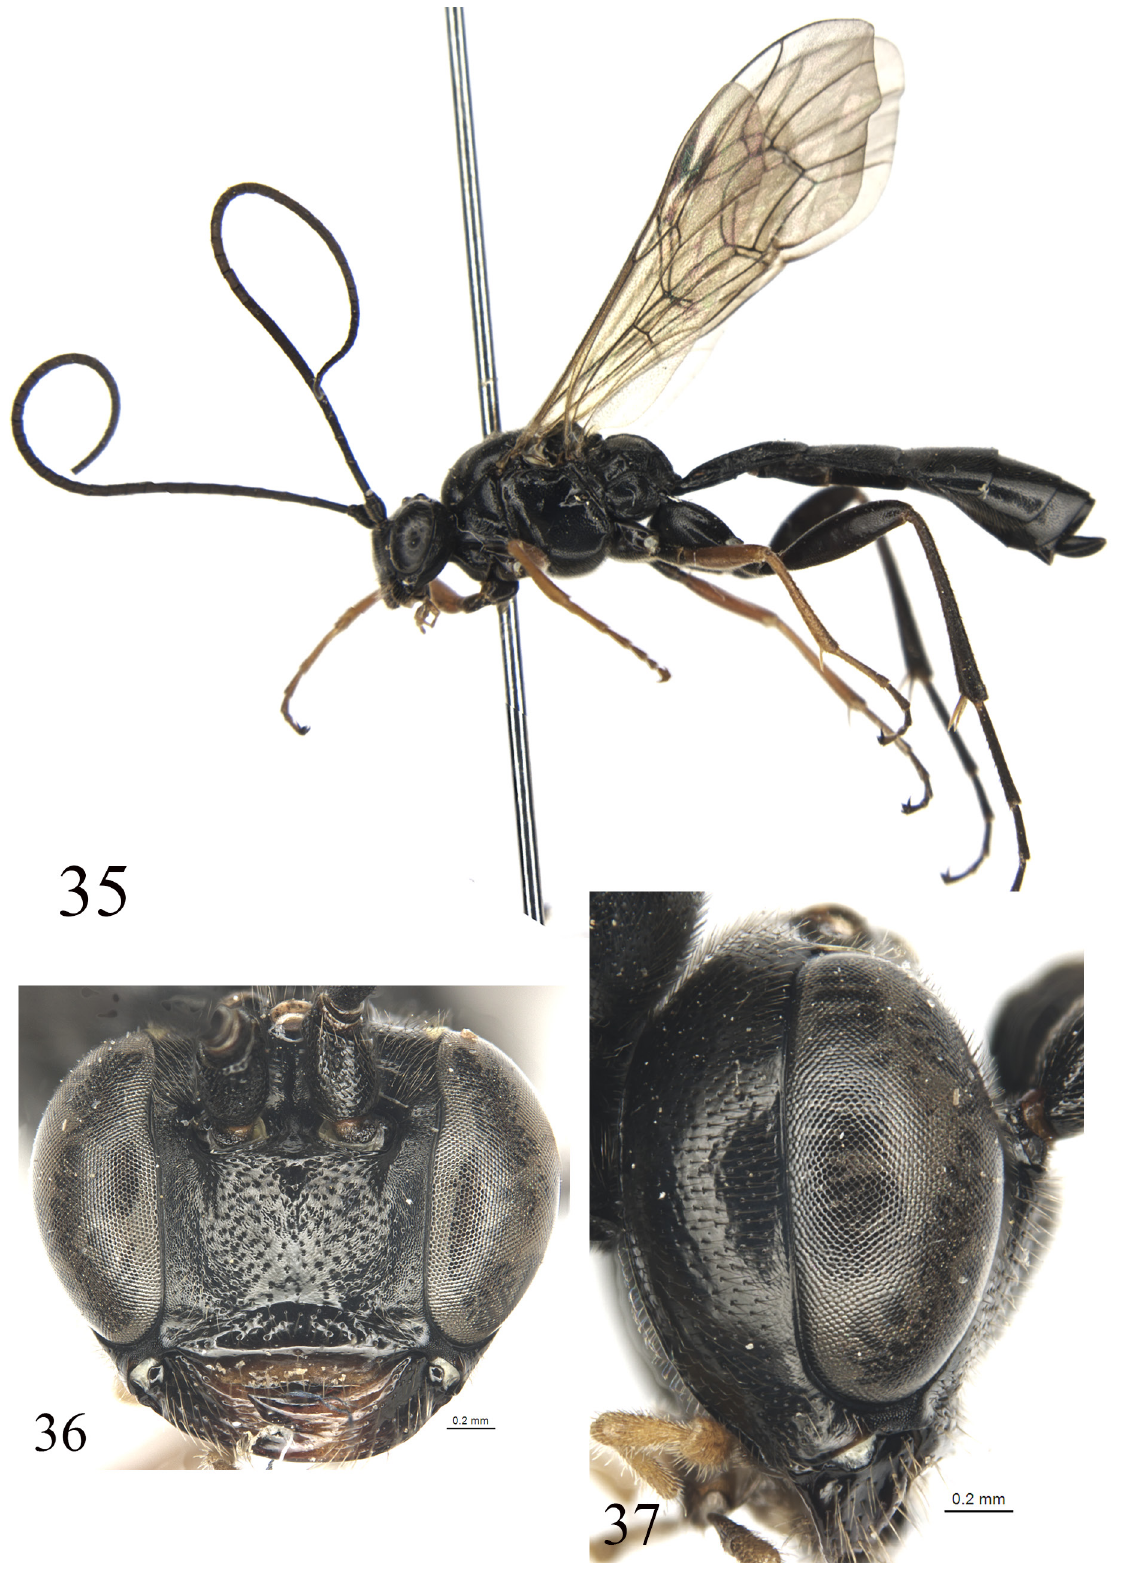
Figs 35–37. Ctenopelma pineatum Sheng, Sun & Li sp. nov., holotype, ♀ (GSFGPM). 35 . Habitus, lateral view. 36 . Head, anterior view. 37 . Head, lateral